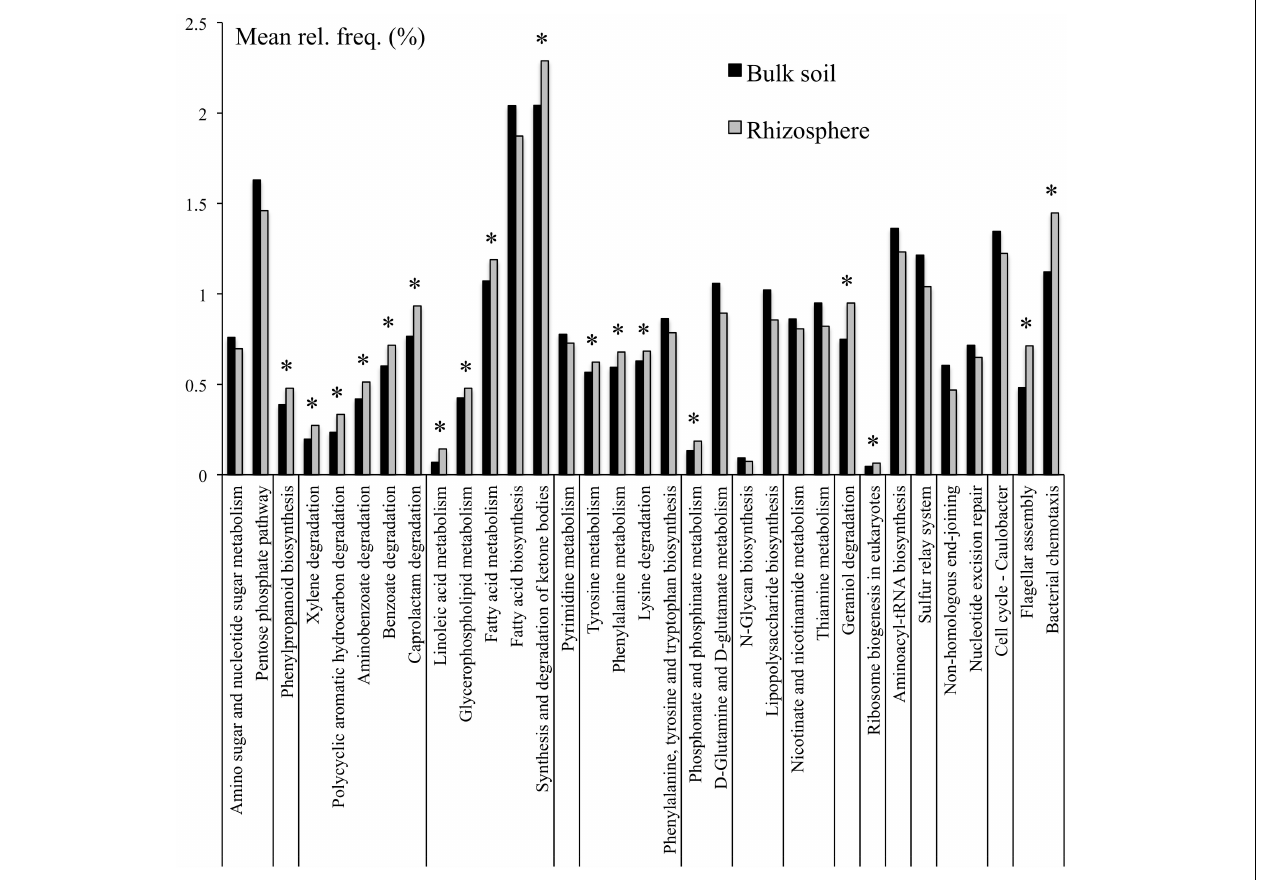
FIGURE 1 | KEGG pathways that were at differential relative abanances between bulk soil and rhizosphere samples. Only pathways with mean relative frequencies > 0.5% are shown. Corrected p- values ( q -values) were calculated based on Benjamini–Hochberg FDR multiple test correction. Features with (Welch’s t -test) q -value < 0.05 were considered significant and were thus retained. ∗ Pathways overrepresented in